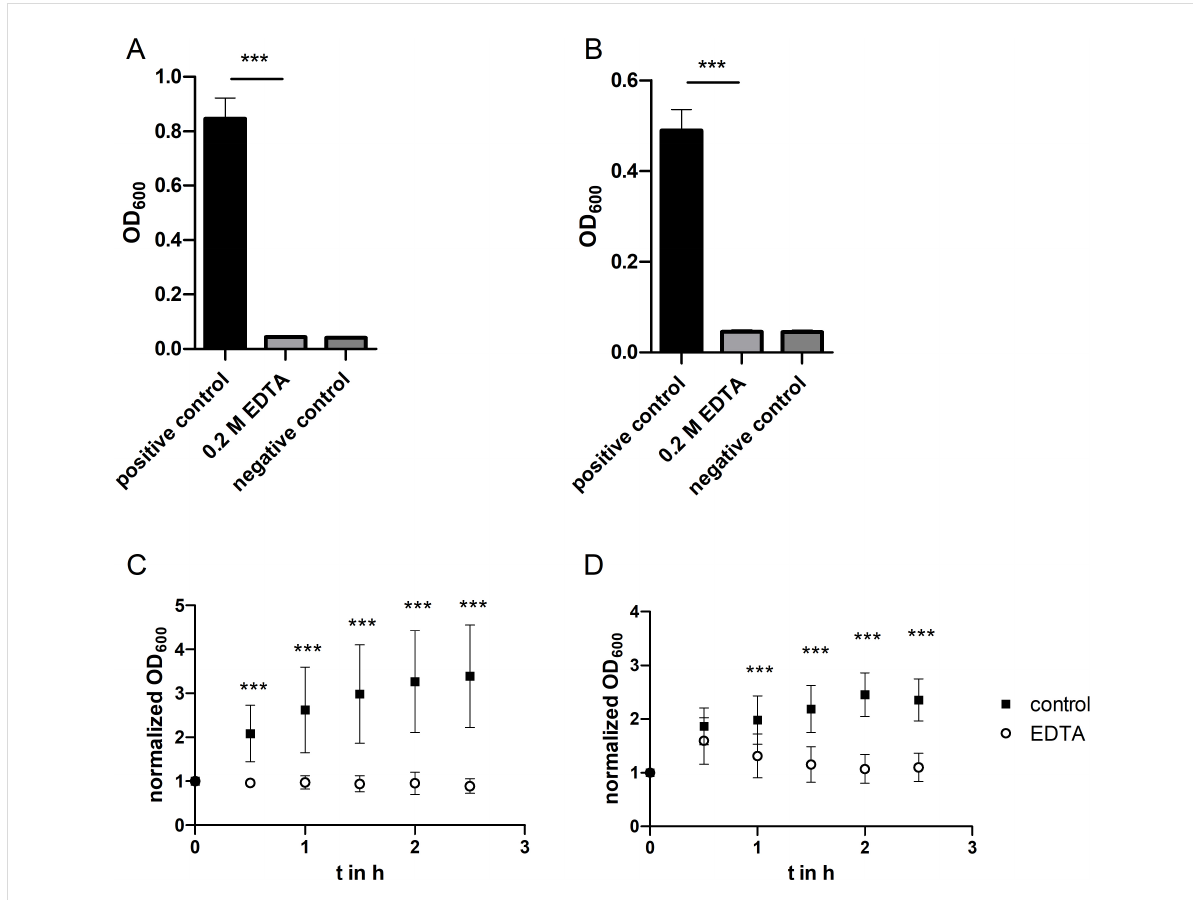
Figure 4: Effect of EDTA on bacterial growth of E. coli and S. epidermidis . E. coli (A) and S. epidermidis (B) cells were incubated for 20 h at 37 °C in Mueller–Hinton II Bouillon (positive control), Mueller–Hinton II Bouillon + 0.2 M EDTA, or Mueller–Hinton II Bouillon + 0.4% peracetic acid (negative control). Error bars are SD ( n = 12 biological replicates). SD for negative controls and 0.2 M EDTA <0.005. E. coli (C) and S. epidermidis (D) cells were preincubated for 20 h at 37 °C in Mueller–Hinton II Bouillon. Afterwards, the growth medium was removed and replaced with fresh Mueller–Hinton II Bouillon (“control”) or Mueller–Hinton II Bouillon + 0.2 M EDTA (“EDTA”). Cells were grown for 2.5 h at room temperature. Error bars are SD ( n = 12 biological replicates). Statistical analysis was performed by a two-way ANOVA Bonferroni’s multiple comparison test; *** corresponds to p <